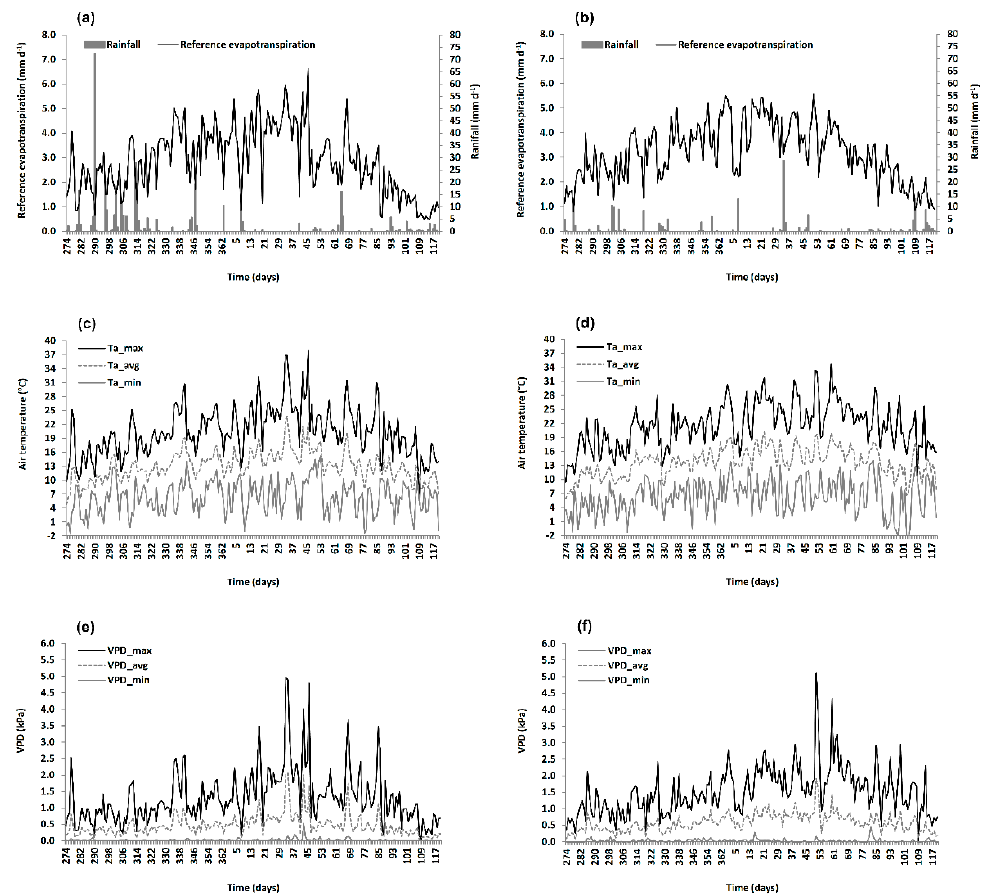
Figure 2. Daily variation of meteorological data registered by an automatic weather station (AWS) located close to study site for the 2018/2019 ( a , c , e ) and 2019/2020 ( b , d , f ) seasons. T a is the air temperature, and VPD is the vapour pression deficit. The abbreviation max, avg and min are the measured variables’ maximum, average, and minimum expression.